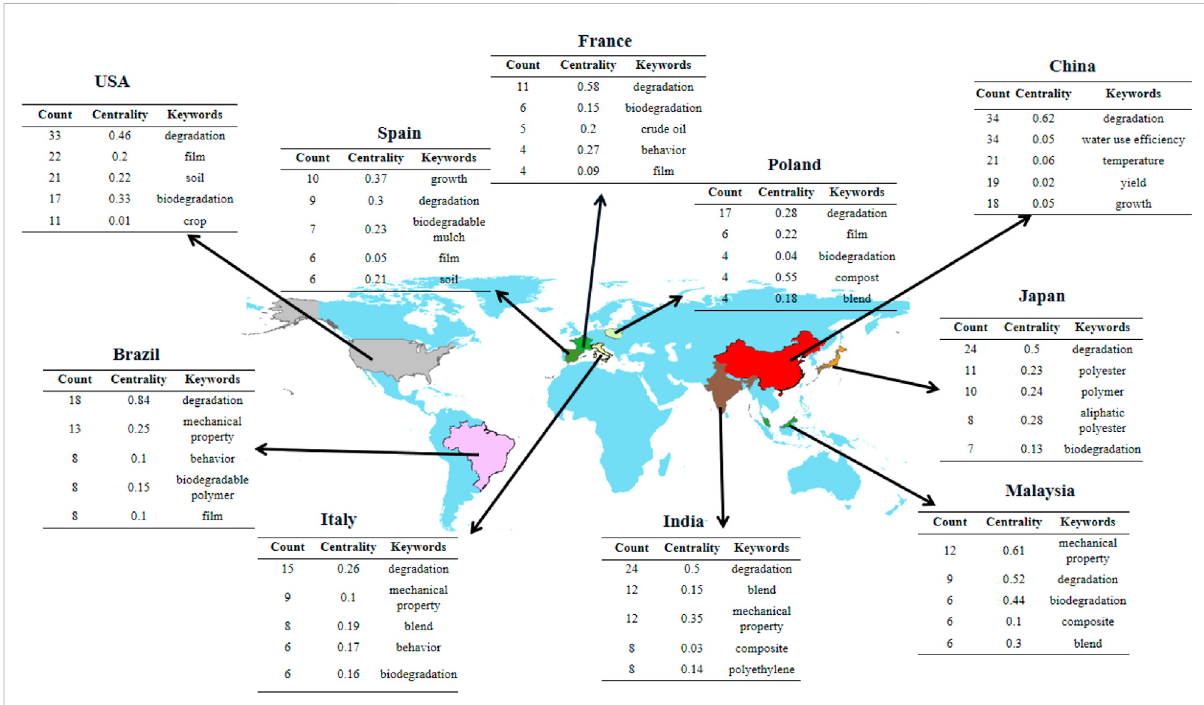
FIGURE 6 The 10 most frequently used keywords in the 10 most in fl uential countries. Note: In the picture, China includes mainland China